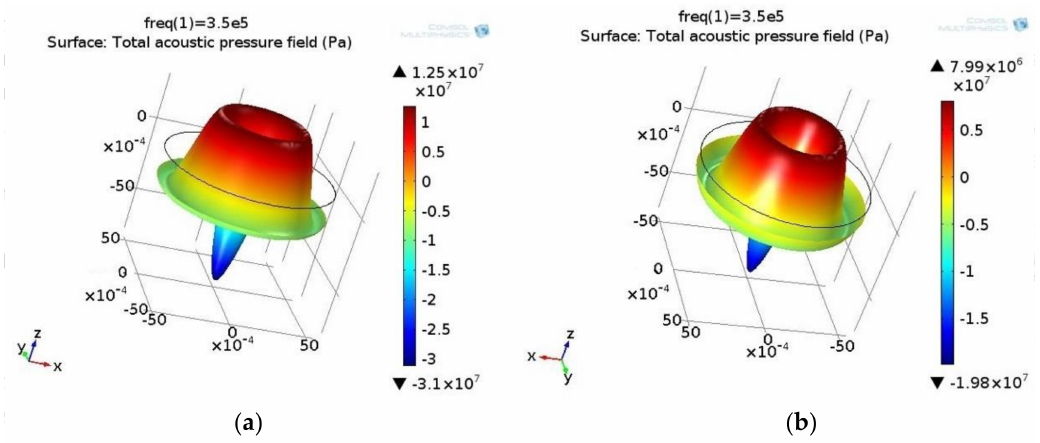
Figure 2. Pressure field (Pa) of the standing wave in ( a ) biological and ( b ) water suspension. Excitation frequency: 350 kHz. The high pressure area is represented in the red and blue areas of low pressure. The values of high and low pressure reach several kPa, but in opposite directions.